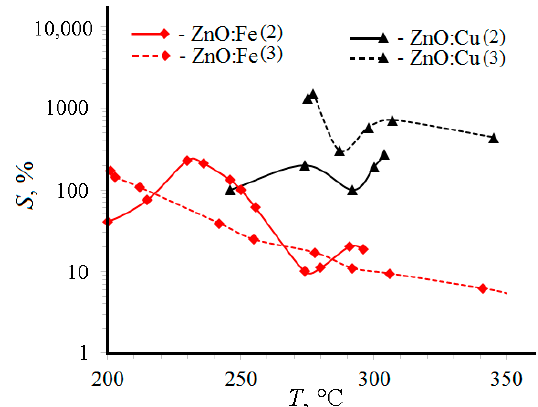
Figure 8. Temperature dependence of gas sensitivity for the ZnO/ZnO–Me samples.